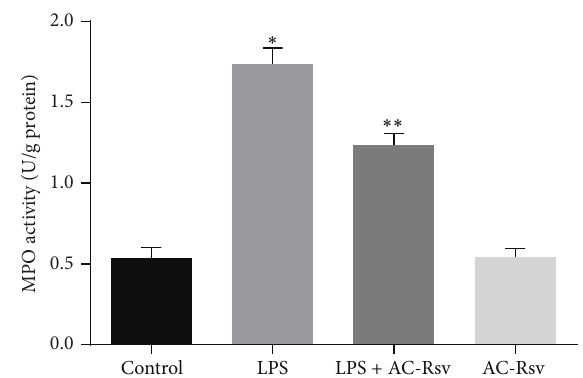
Figure 4: Effects of AC-Rsv on MPO activity in lungs stimulated by LPS. Data are expressed as mean ± S.D. 𝑛 = 8 . LPS injection significantly increased the MPO activity in lung compared with that of control, ∗ 𝑃 < 0.05 versus control, while pretreatment of AC-Rsv dramatically inhibited the elevating effects of LPS on MPO activity, ∗∗ 𝑃 < 0.05 versus ∗ 𝑃